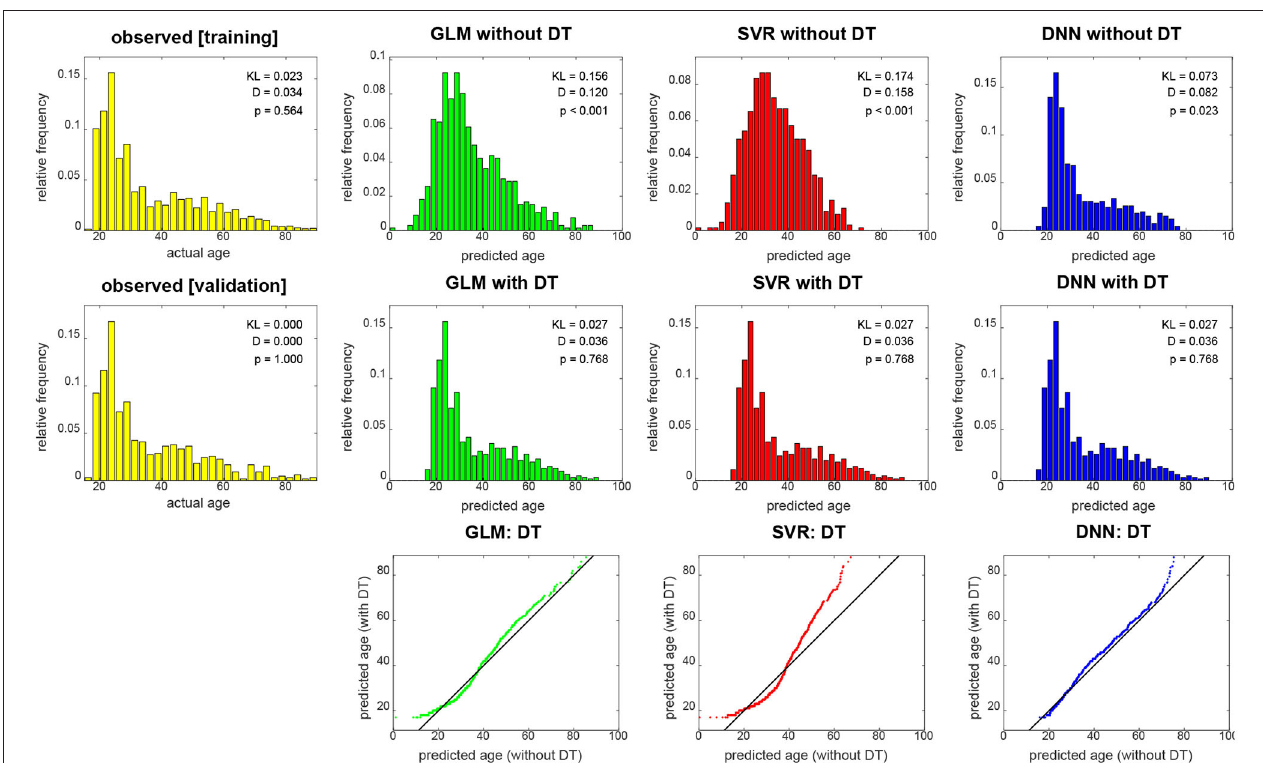
FIGURE 4 | Empirical distributions of actual age (yellow), predicted age (top) and transformed age (middle) . Each panel shows relative frequencies, i.e., number of occurrences divided by total number of subjects. The applied distributional transformation is shown for each decoding algorithm (bottom) , with the diagonal line denoting the identity function. The empirical KL divergence was always computed relative to the validation age distribution (middle row, left), thus this distribution has KL = 0. Also reported are statistics from a two-sample Kolmogorov–Smirnov test between predicted values and validation ages, thus D = 0 and p = 1 for validation set age. GLM, multiple linear regression; SVR, support vector regression; DNN, deep neural network regression; DT, distributional transformation; KL, Kullback–Leibler